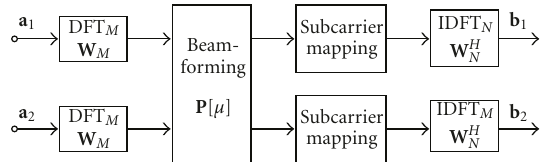
Figure 1: Transmitter with SC-FDMA signal processing and beam-